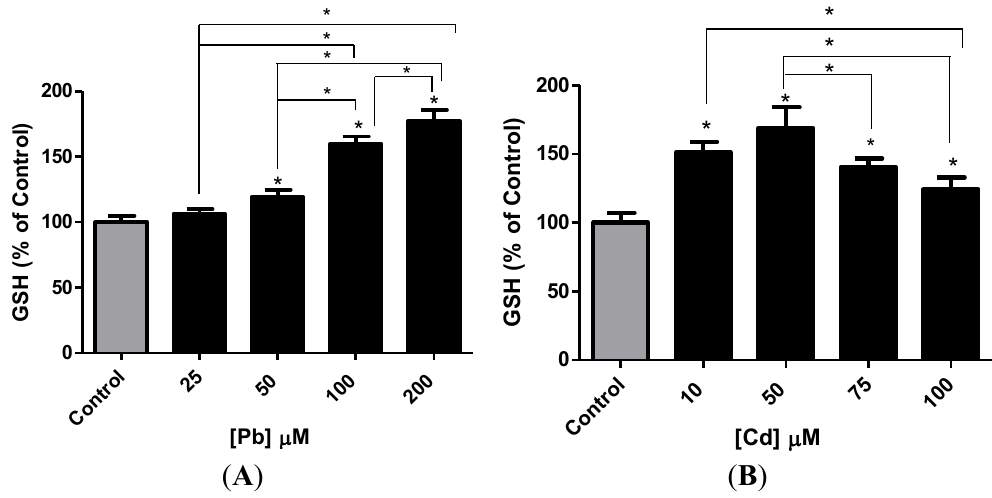
Figure 3. Intracellular GSH levels in hCMEC/D3 cells after treatment with ( A ) Pb and ( B ) Cd. Cells were exposed to different concentrations of Pb (25–200 µM) and Cd (10–100 µM)